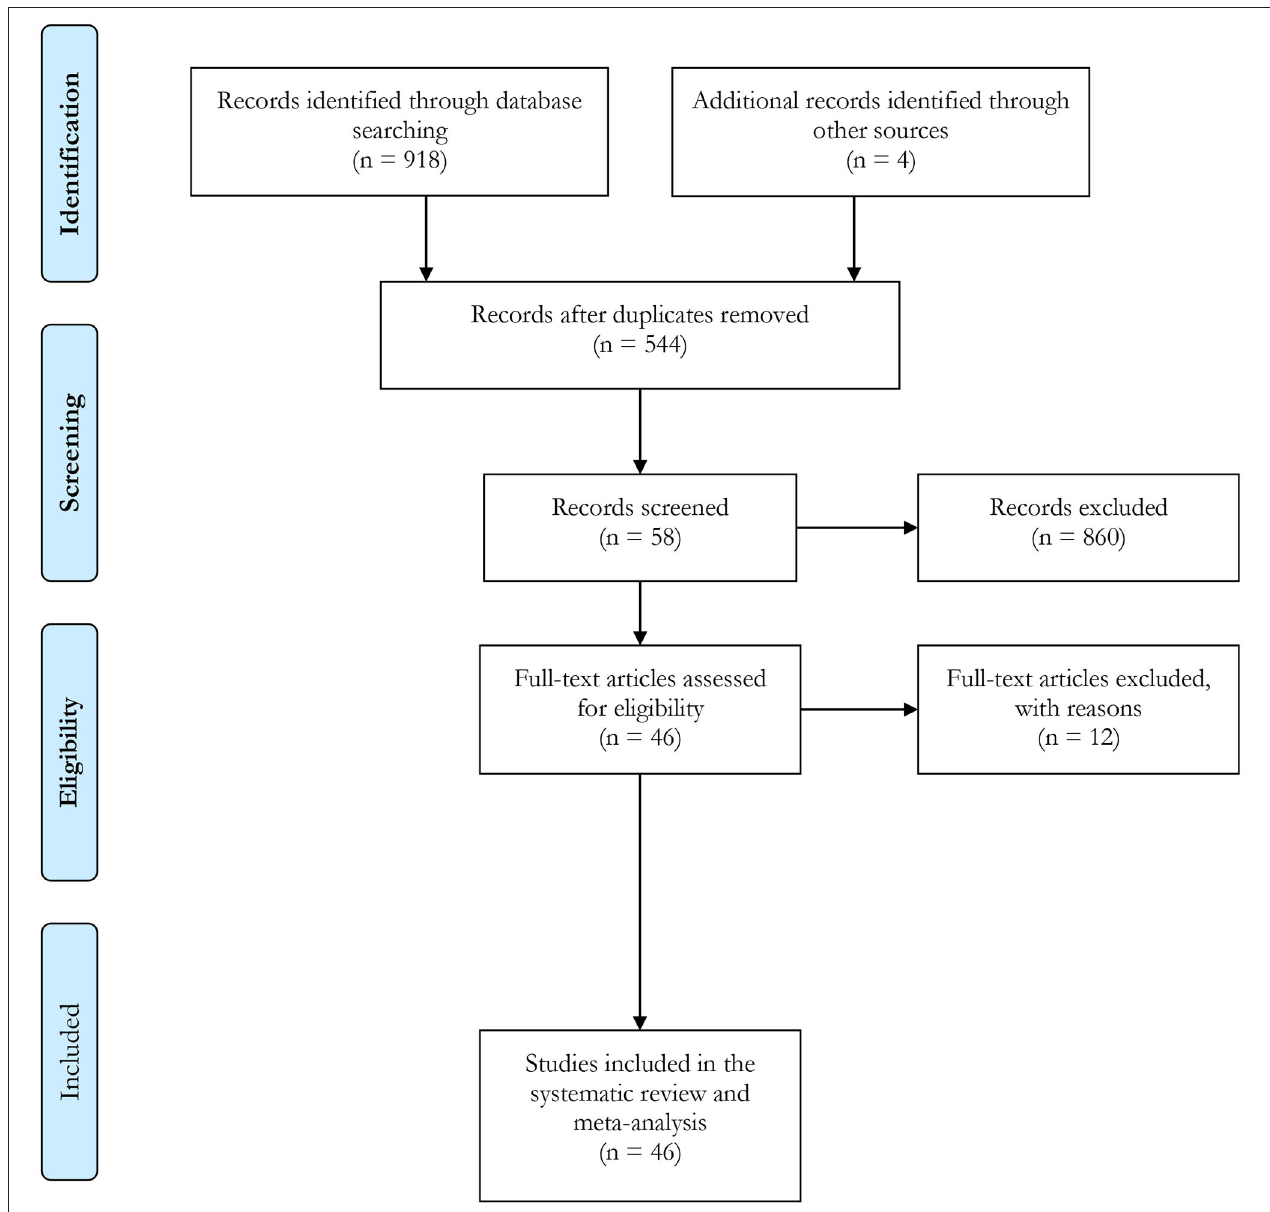
FIGURE 1 | Flow diagram of study selection